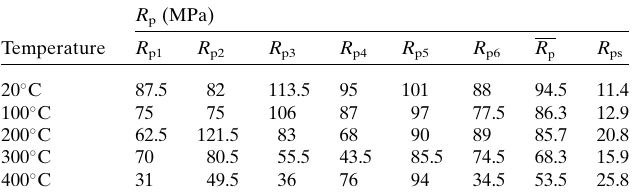
Table 5 Yield strength of TIG joints.